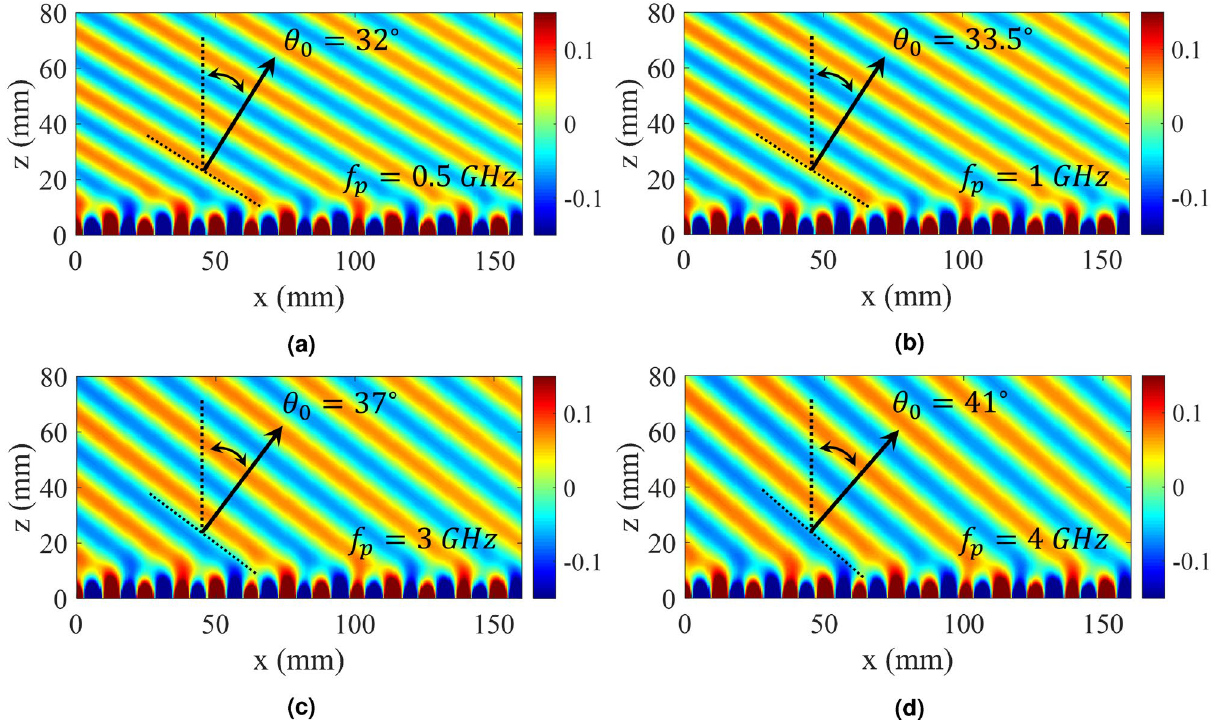
Figure 12. Total fields for different values of pumping frequencies. ( a ) f p = 0.5GHz , ( b ) f p = 1 GHz , ( c ) f p = 3 GHz , and ( d ) f p = 4 GHz